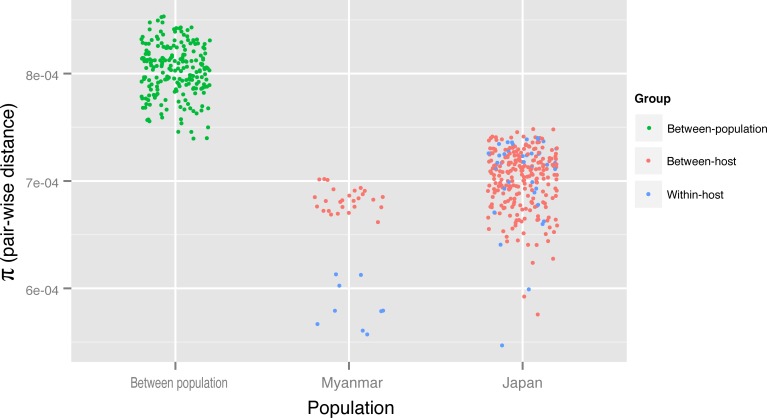
Pair-wise genetic distances (π) of genomes between samples.Distances between samples from Japan and Myanmar (green dots) were generally higher than those of the same country. Inter-host comparisons (red dots) show higher πvalues than those of within-host comparisons (blue dots) in Myanmar. The differences are ambiguous in the Japanese samples.